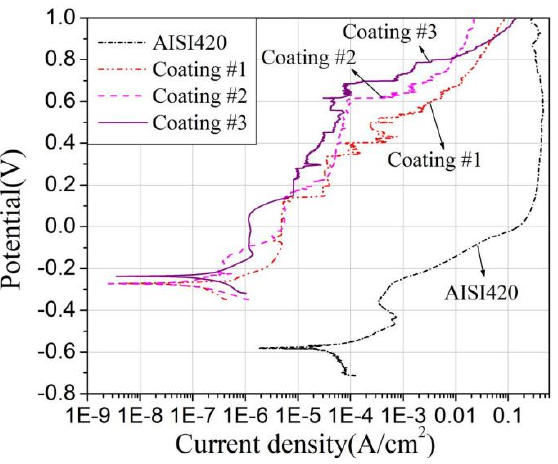
Figure 10. Polarization curves of different samples in 5.0 wt% NaCl + H 2 SO 3 solution (pH = 3 ± 0.2).